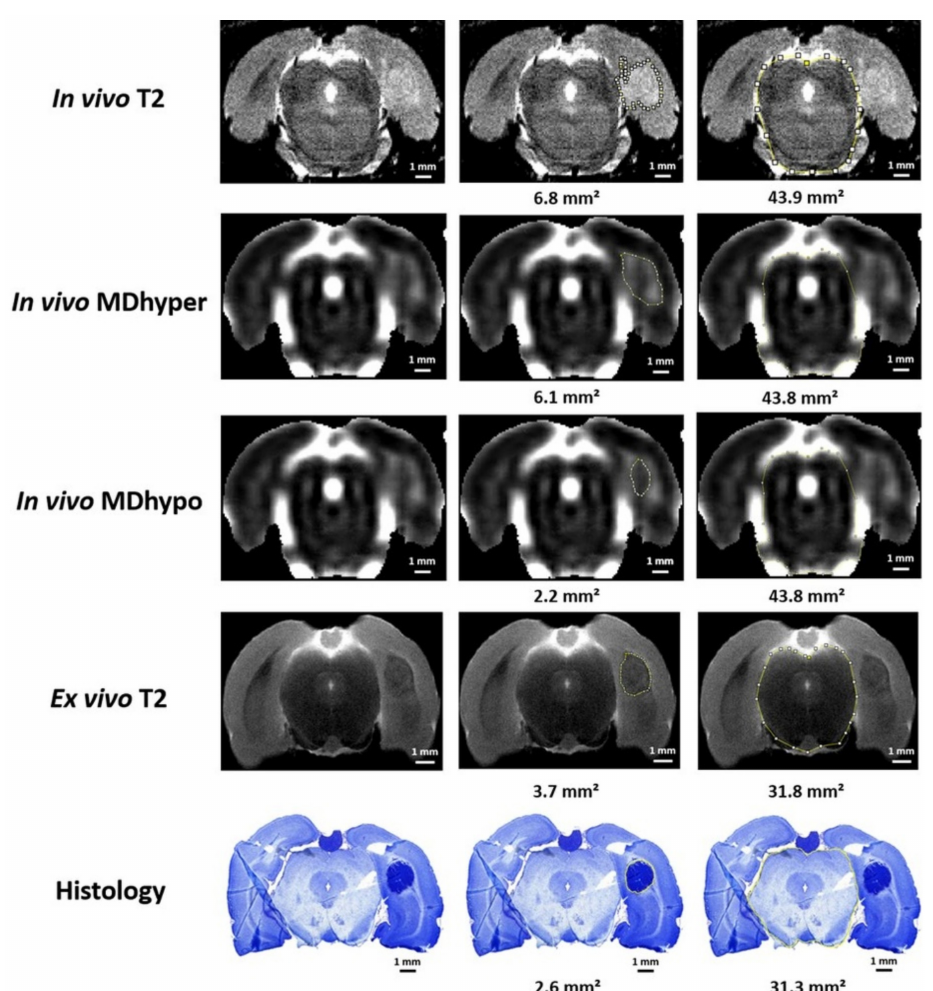
Figure 1. In vivo MRI, ex vivo MRI and histological analysis in GB04. In this figure, examples of in vivo T2w, in vivo MD, ex vivo T2w and histological images are shown in the first column. In the second column, the region of the estimated abnormal mass or tumor tissue is marked on these images. The third column shows the delineation of the brainstem. Calculated areas of the marked regions are indicated underneath the images. Note that exact one-by-one comparisons of slices from different modalities are not possible, as slices of the exact same locations for in vivo MRI, ex vivo MRI and histology were not available and as the slice thickness on MRI (0.6 mm) does not match the slice thickness of histological slices (20 µ